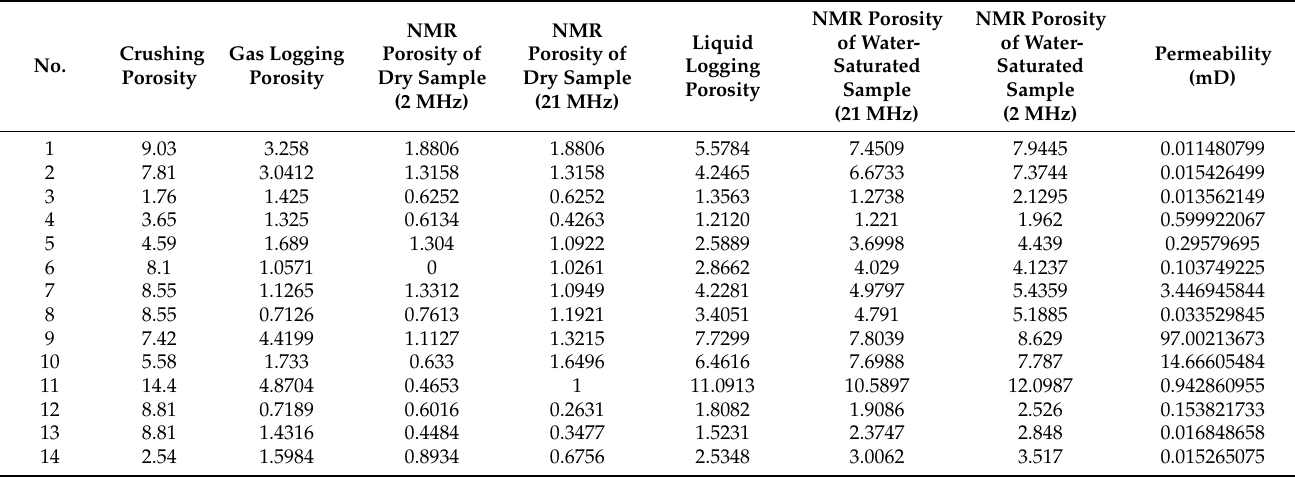
Table 1. Basic test data of shale core